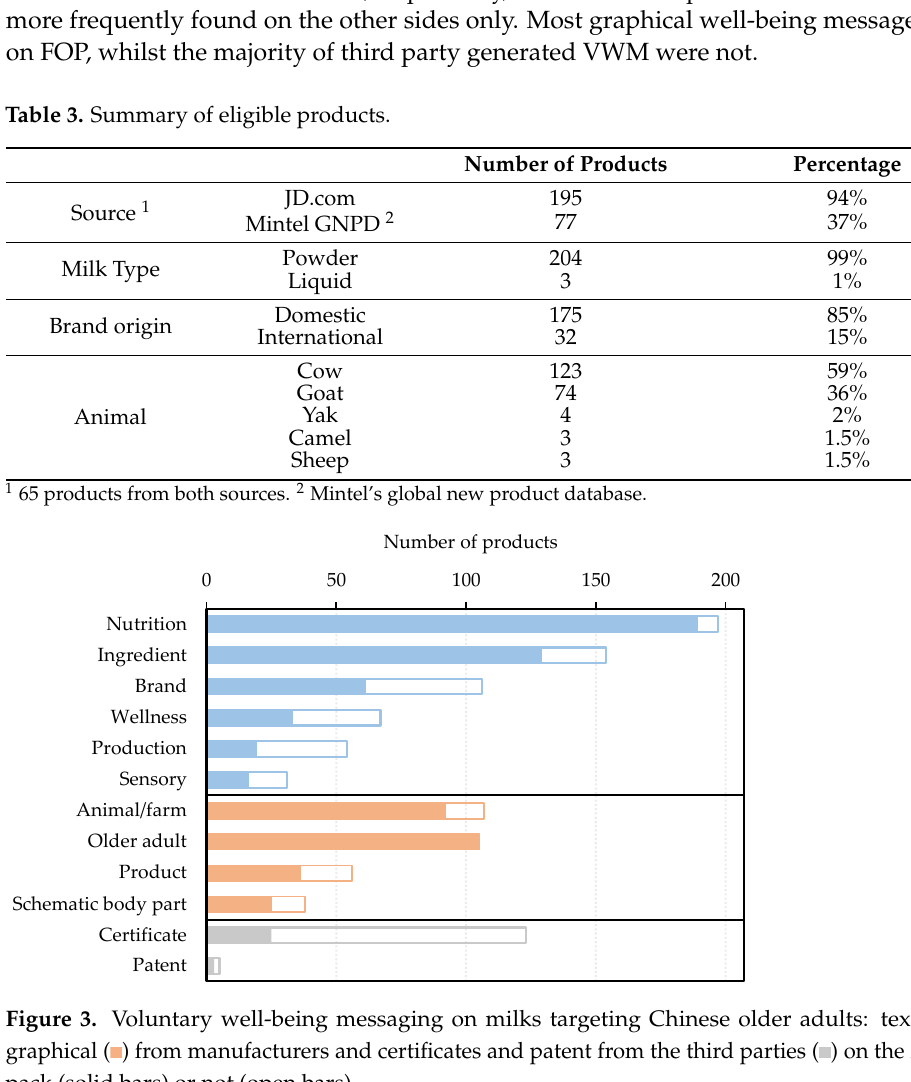
) on the front-of-